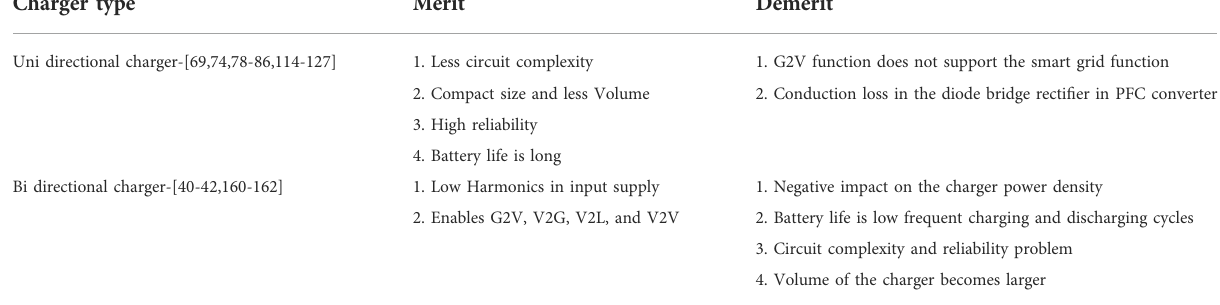
TABLE 10 Unidirectional and bidirectional charger comparison.